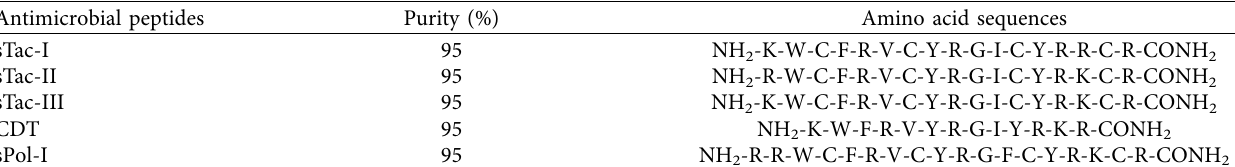
Table 1: Te amino acid sequences of the sLAMPs used in this